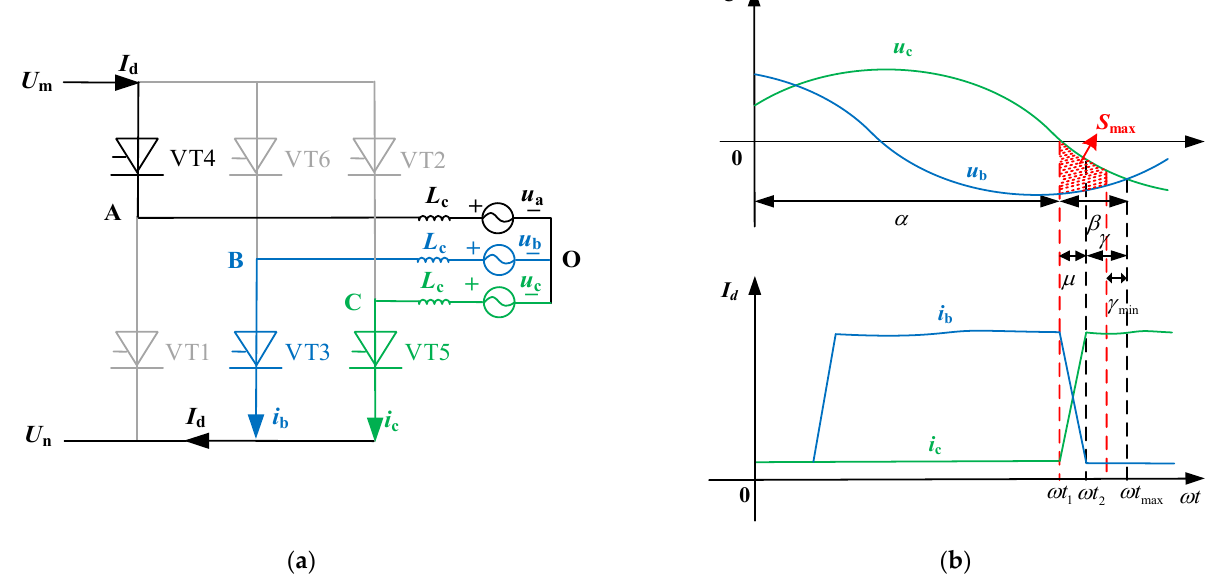
Figure 2. Mechanism analysis of commutation process. ( a ) Equivalent model of inverter side 6-pulse converter. ( b ) Simplified diagram of inverter commutation process.